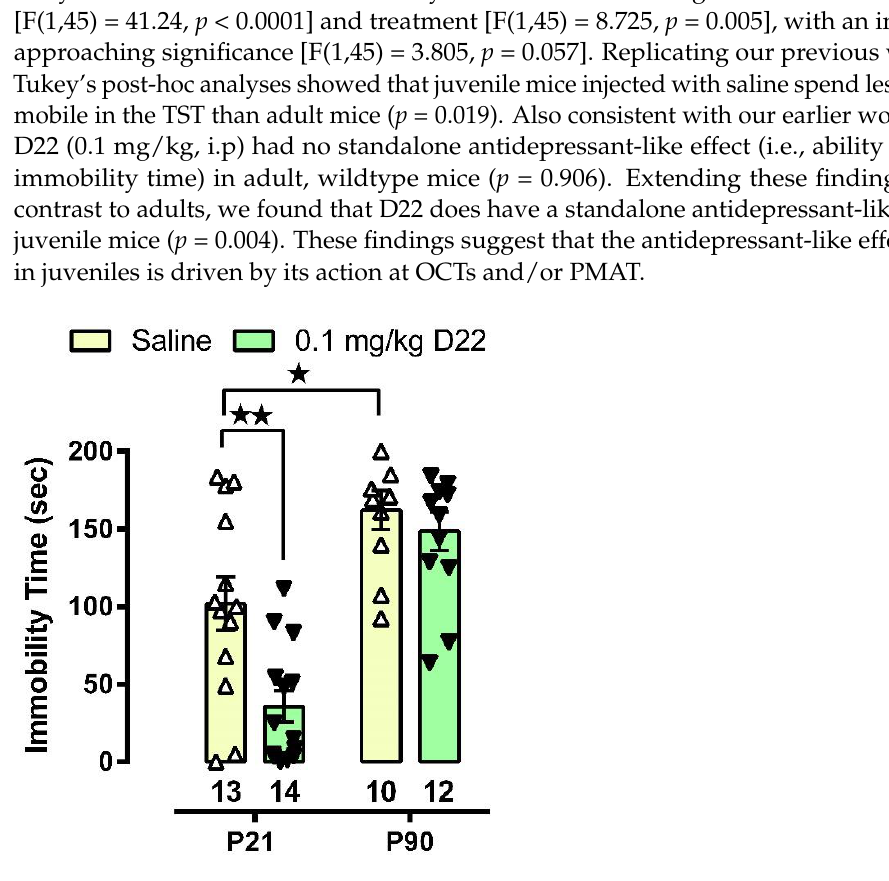
Figure 1. Blockade of OCTs and PMAT with D22 produces an antidepressant-like effect in juvenile (P21) mice but not in adult (P90) mice. Immobility time (s) in the TST after acutely administered saline (open bars, open triangles) or D22 (green bars, filled inverted triangles). Tukey’s post hoc test for multiple comparisons after a two-factor ANOVA. * p < 0.05 and ** p < 0.01 significant difference from vehicle. Data are mean ± S.E.M. Sample size is indicated under each